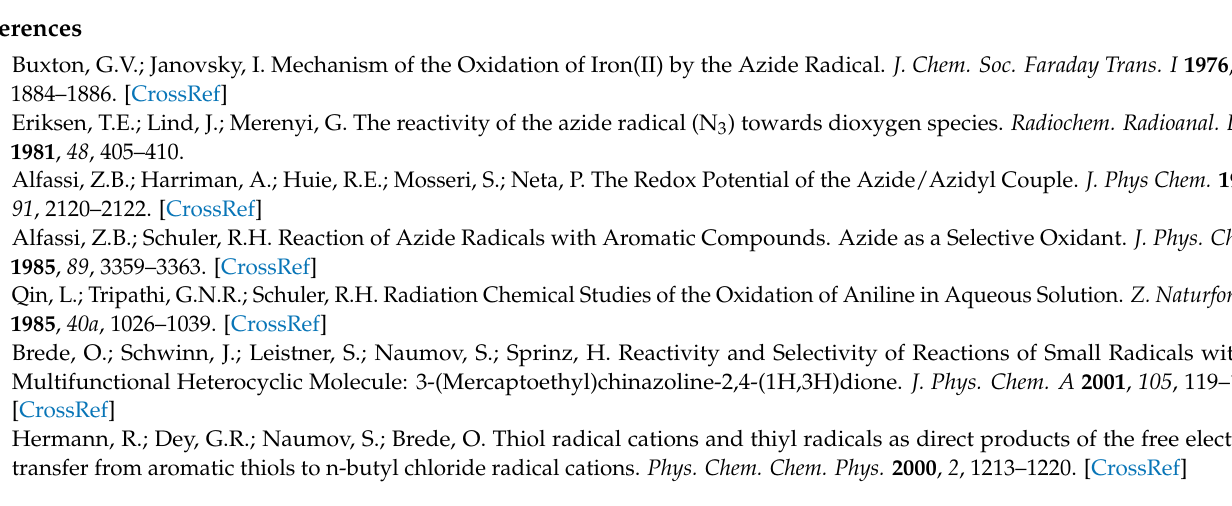
growth of transient absorptions at λ = 530 nm recorded after the electron pulse in N 2 O-saturated aqueous solutions at pH = 11.3 containing 0.1 M NaN 3 and various concentrations of 7-OCH 3 -3-MeQ. Figure S7. Comparison of the transient absorption spectrum recorded in Ar-saturated aqueous solutions containing 0.1 mM 7-OCH 3 -3-MeQ, 0.1 M K 2 S 2 O 8 and 0.5 M tert-BuOH at pH = 4 and 7 and the u- ω B97XD/aug-cc-pVTZ calculated UV-Vis spectra of the 7-OCH3-3-MeQ • + and 7-OCH3-3- MeQ • species. Figure S8. Structures of the N 3 • adducts at the C2 and C3 carbon atoms in 3-MeQ. Table S1. Reduction potentials of inorganic redox couples used in the study. Table S2. pK a values of the acid-base equlibria of 7-R-3-MeQ